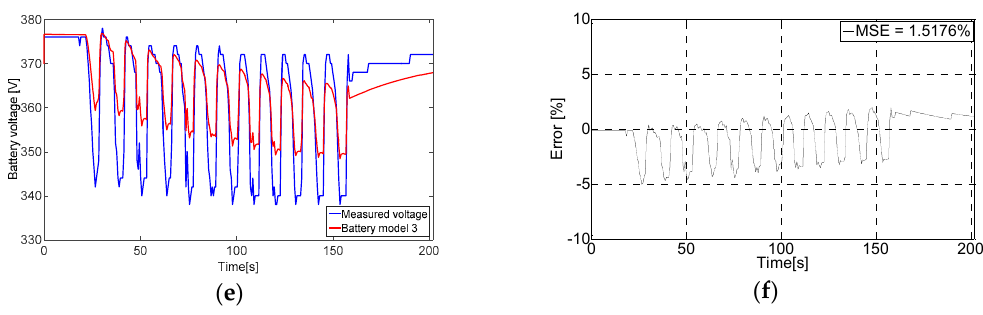
Figure 10. Battery simulation models and reference voltage signal for rapid acceleration and deceleration driving test: ( a ) Battery model 1 response; ( b ) Mean square error of battery model 1; ( c ) Battery model 2 response; ( d ) Mean square error of battery model 2; ( e ) Battery model 3 response ( f ) Mean square error in battery model 3.